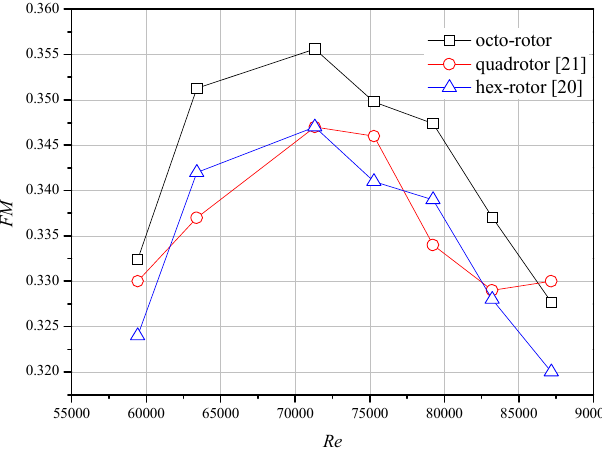
Figure 6. The FM comparison with quadrotor and hex-rotor.